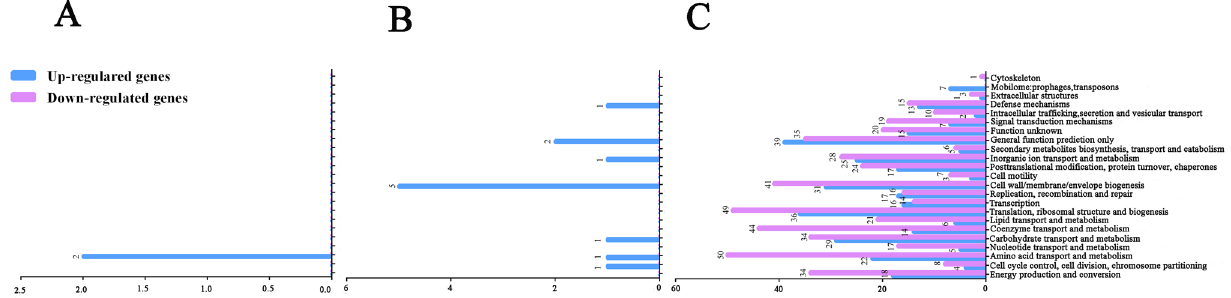
Figure 3. COG annotations of DEGs. ( A ) to ( C ) DEGs in BM0.05, BM0.2 and BM0.5 groups in the COG database,